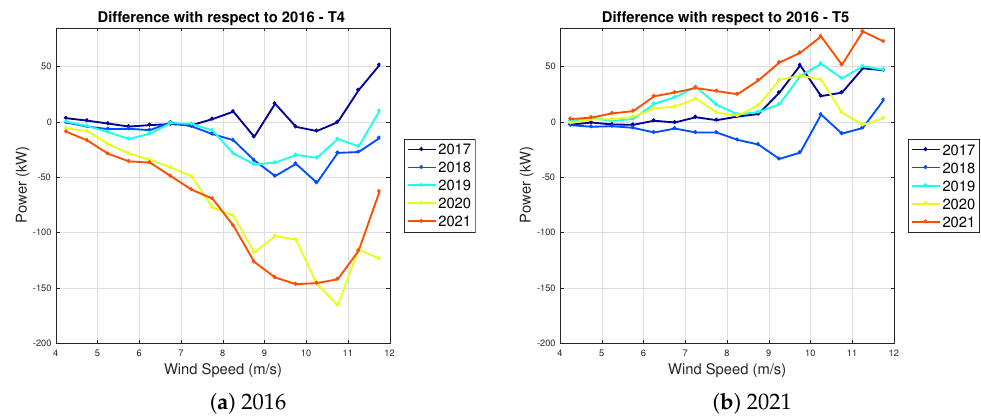
Figure 9. Difference of the power curve with respect to 2016, for wind turbines T4 and